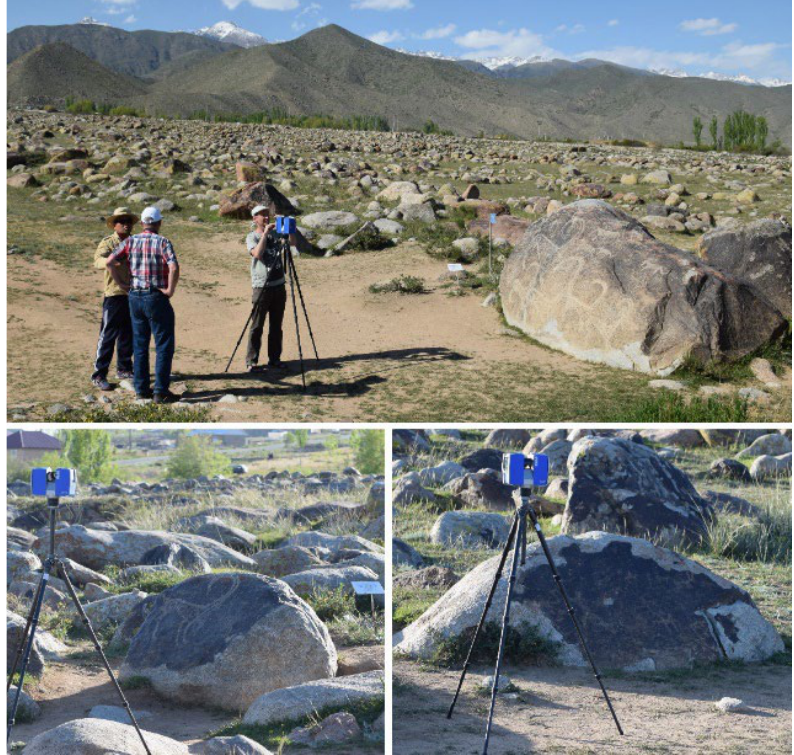
Figure 6. Implementation of the scanning of petroglyphs in the museum in Cholpon-Ata. Source: authors’ own.